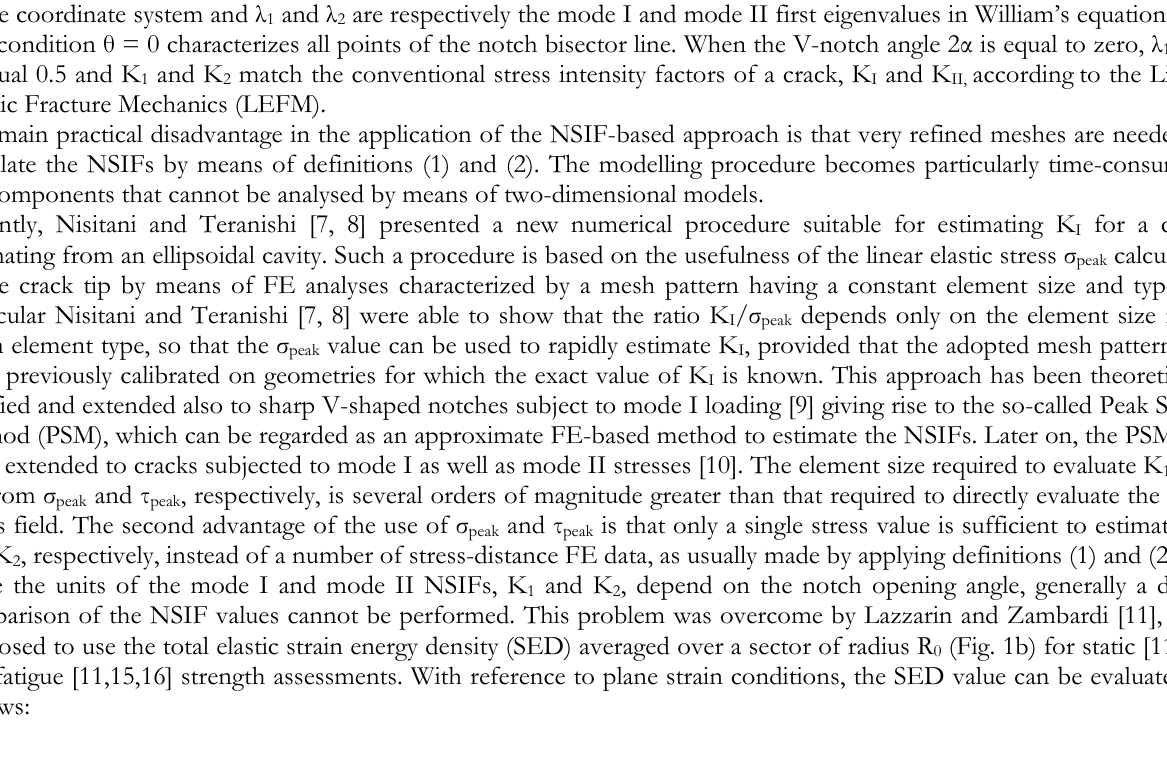
Figure 1: (a) Polar coordinate system centred at the notch tip. (b) Control volume (area) of radius R 0 surrounding the V-notch tip. where (r, θ ) is a polar coordinate system centred at the notch tip (Fig. 1a), σ θθ and τ r θ are the stress components